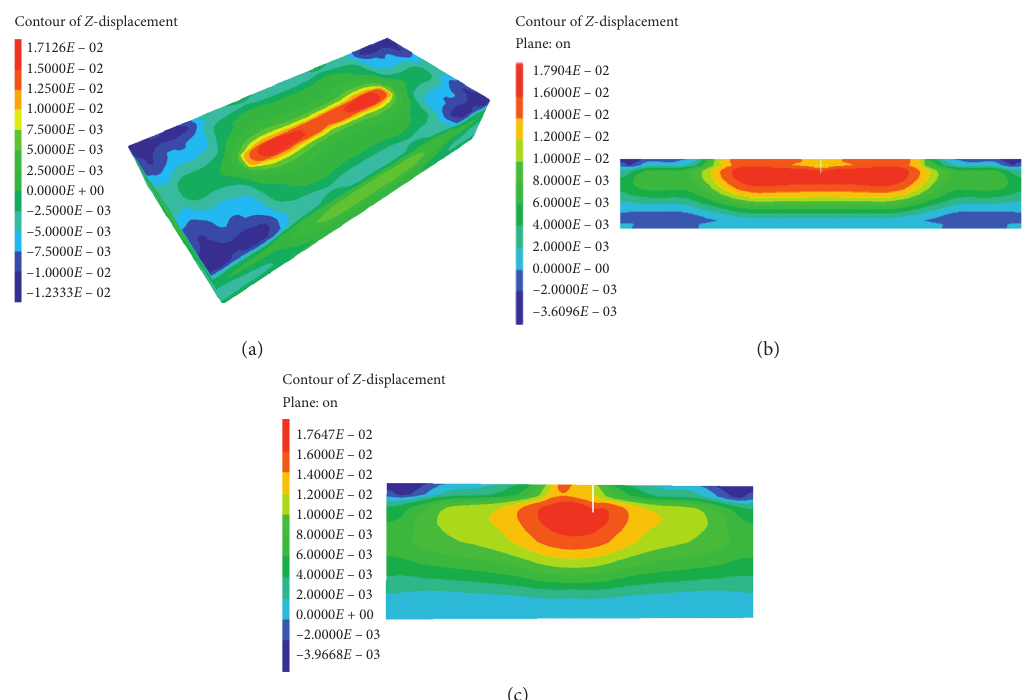
Figure 16: Single well subsidence nephogram after the first drawdown (unit: m). (a) Three-dimensional diagram. (b) Cross section of the well midpoint. (c) Longitudinal section of the well